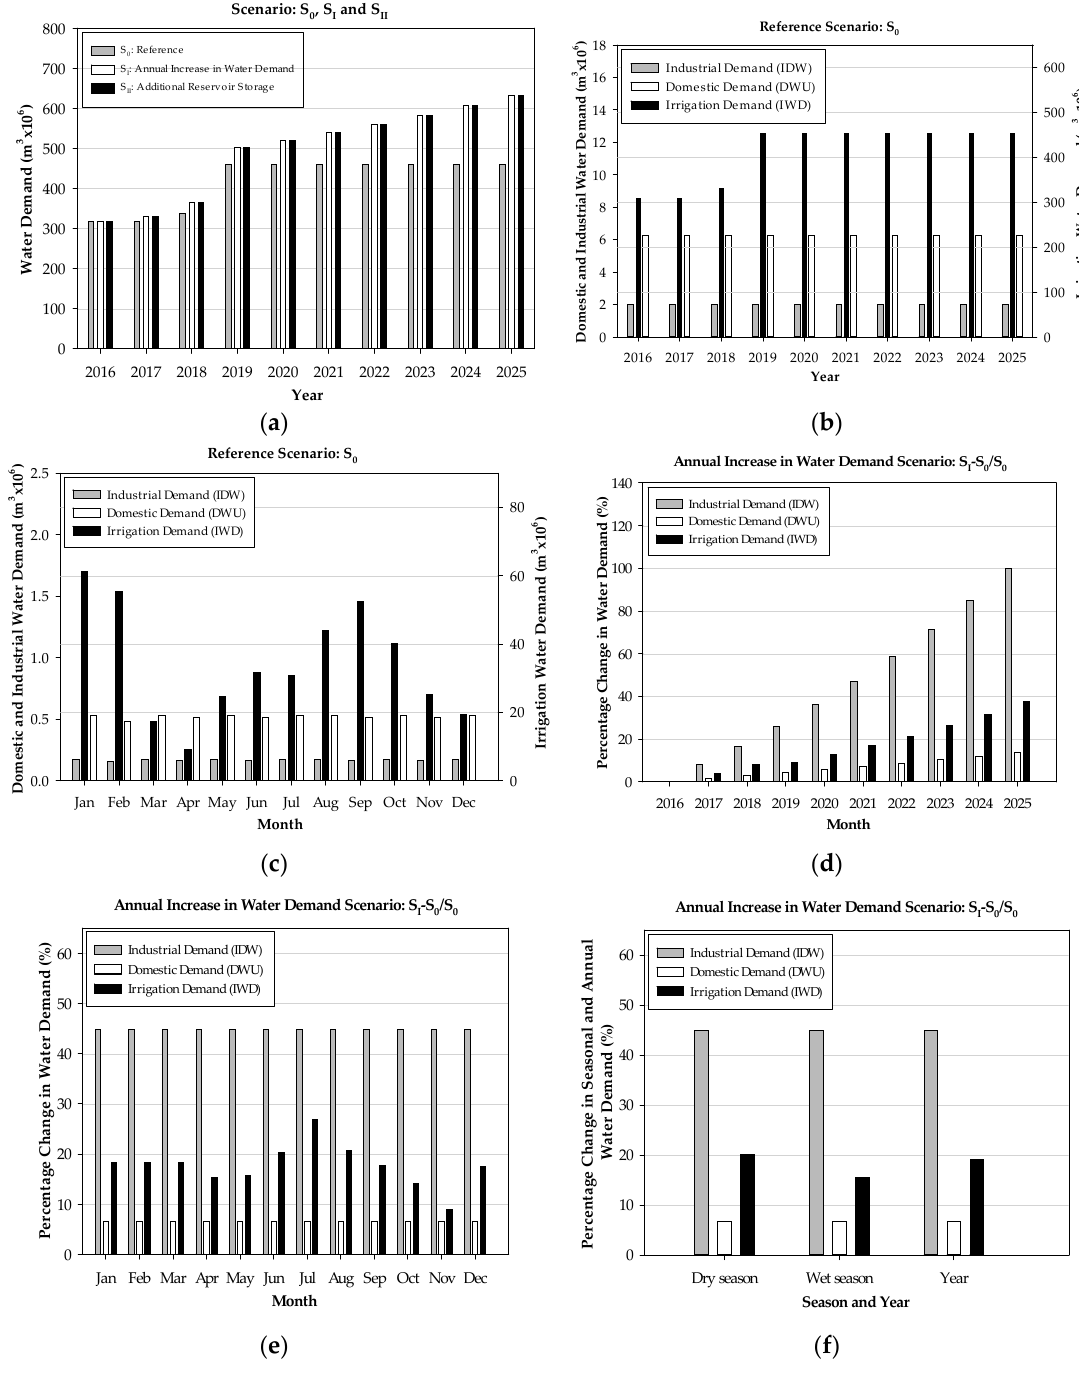
Figure 8. ( a ) The comparison of water demand between different scenario, ( b ) The comparison of annual water demand by each purpose in So, ( c ) The comparison of monthly water demand by each purpose, ( d ) The percentage change in annual water demand in S I , ( e ) The percentage change in monthly water demand in S I , ( f ) The percentage change in seasonal and annual water demand in S I . Furthermore, the highest percentage of monthly IWD increase was 26.9% in July while IDW and DWU show non-signification variation of monthly increase (Figure 8e). The percentage of seasonal and annual increase of IWD was 20%, 15.5%, and 19% in dry, wet season and annual, respectively (Figure